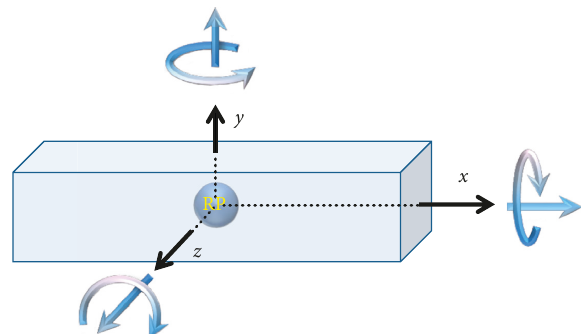
Figure 1: The 6 degrees of freedom of the motion of a rigid body and the definition of the reference point